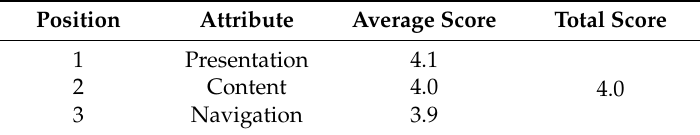
Table 10. Results of Instrument 3, physician profile.